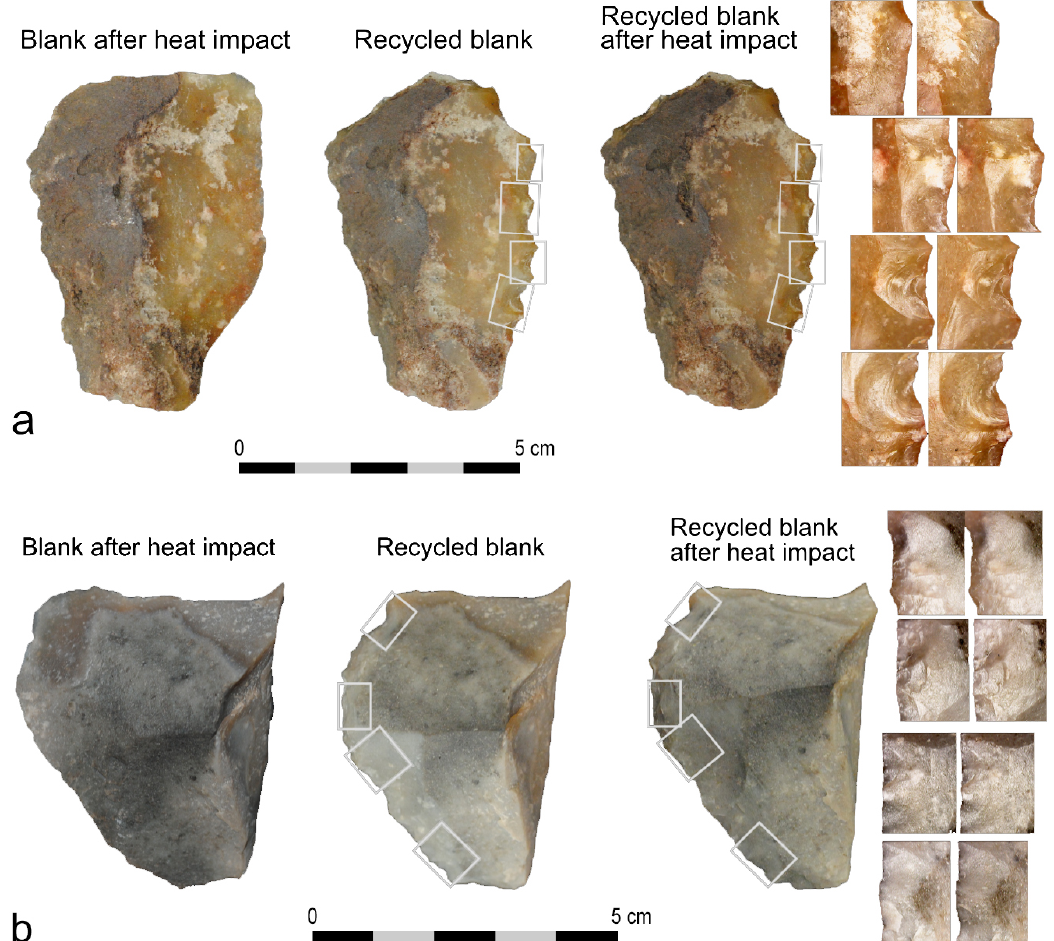
Figure 14. Macroscopic and detail photos of a) Bergerac and b) SMM flint blanks that went under heat impact, were recycled and went through heat impact again. In all cases it was possible to distinguish recycled surfaces through retouch from non-recycled